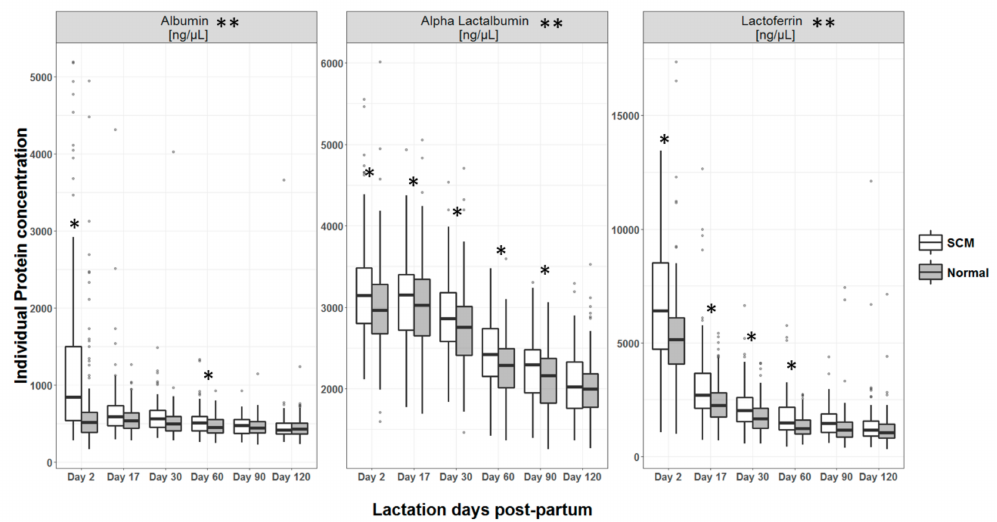
Figure 3. Concentrations of individual proteins in HM across lactation by presence or absence of SCM. * Statistical significance of the di ff erence between mothers with SCM and without SCM for a particular time point with p value < 0.05, ** p value for overall di ff erence between groups <